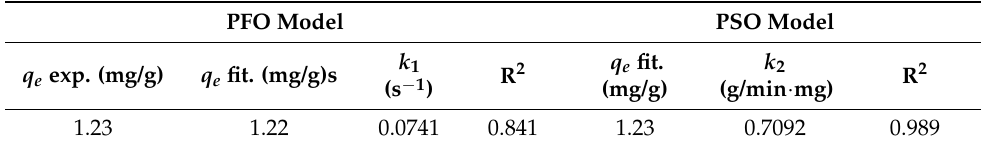
Table 6. Parameters of the PFO and PSO kinetic models. PFO Model